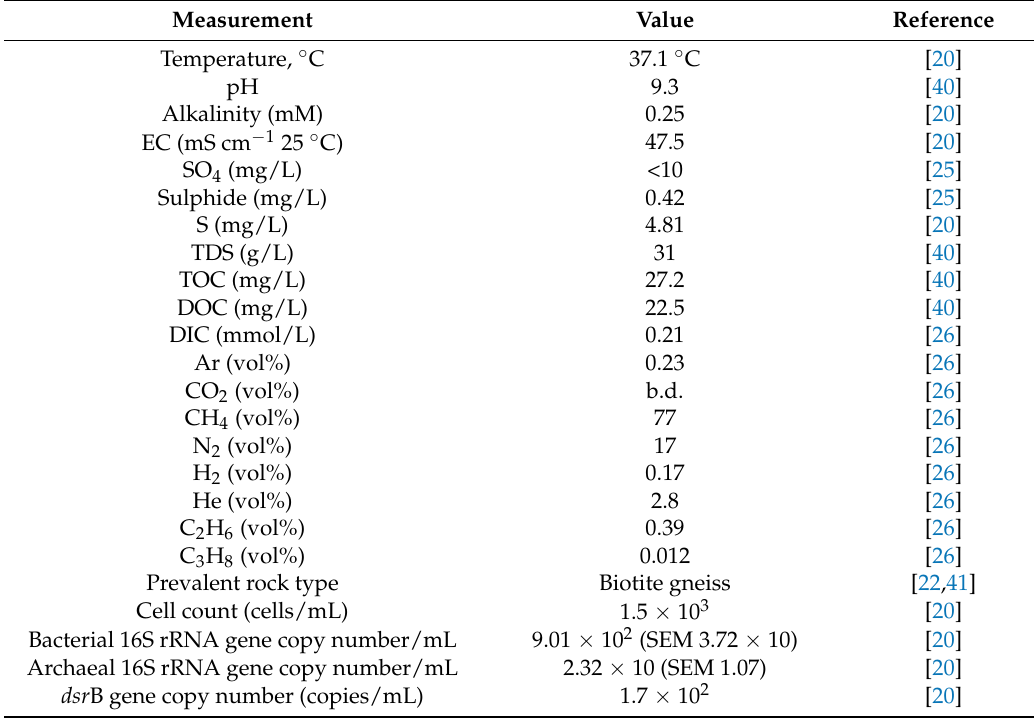
Table 1. Hydrogeochemical characteristics of water and gas samples, and fluid cell count values in Outokumpu subsurface at the depth of 2260